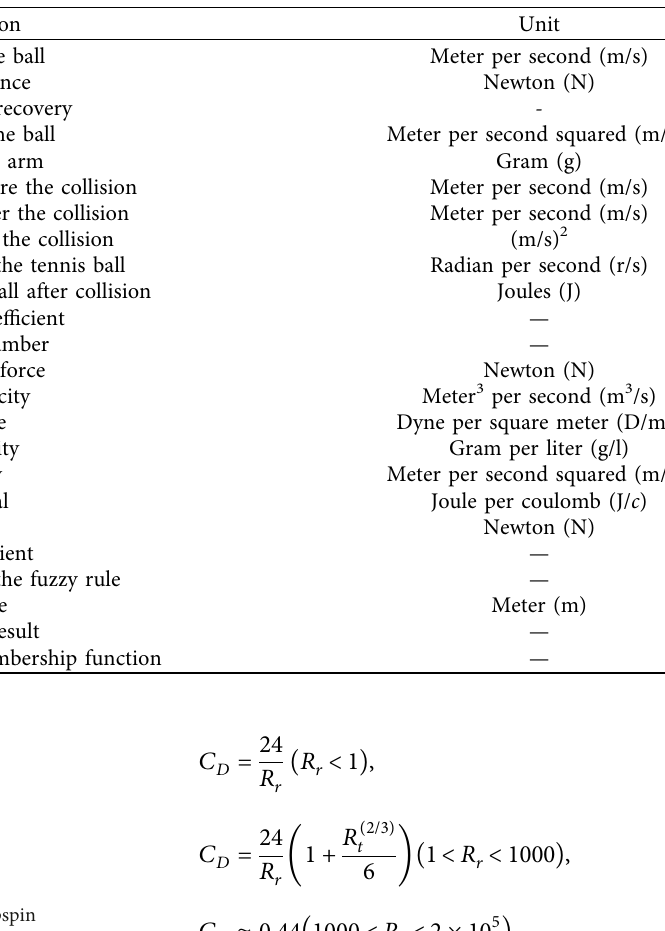
Table 2: The parameters, description, and related units of the problem.